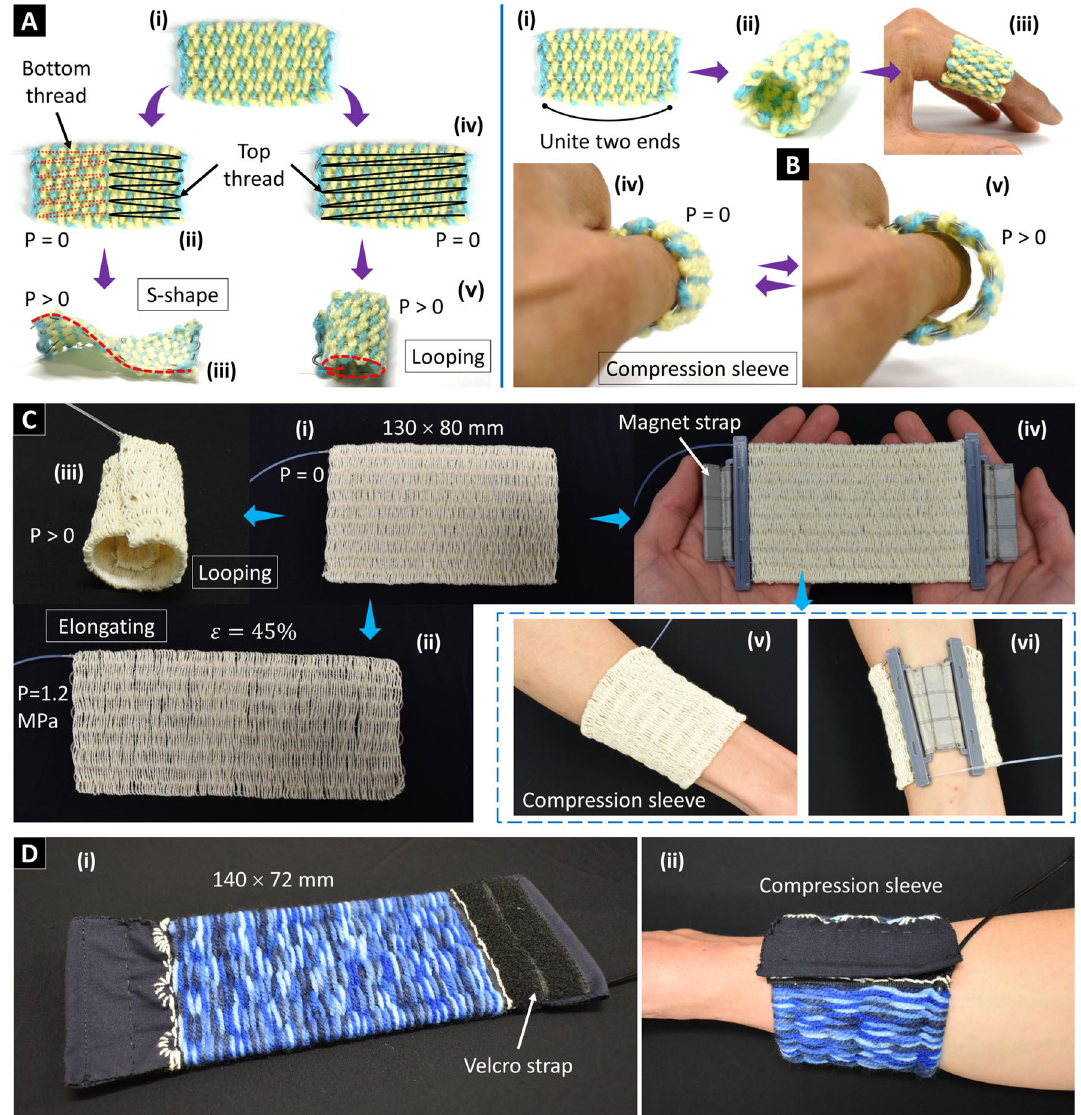
Figure 6. Capabilities of unidirectional weaving sheets. ( A ) Shape programmability by sewing thread to produce shape-shifting structures. ( B ) Compression sleeve for a finger. ( C ) Another weaving sheet embodiment and its implementation as a forearm compression sleeve. ( D ) Another compression sleeve prototype made of an AMF type M, acrylic yarns, and a Velcro strap. Detailed specifications can be found in the “Methods” embraced the human index finger (Fig. 7C). The meandering features of the knitting sheet offer great conform- ability and deformability, facilitating its use in smart garments (gloves, compression sleeves) that provide the wearers with comfort (by adaptability) and therapeutic effect (by compression force). Radial expansion. Besides 2D radial expansion in multiple directions, the circular weaving sheet can also be programmed to form a 3D structure. We constrained the centerline of the circular weaving sheet with acrylic yarns to disrupt its uniform radial expansion. As a result, the initial planar shape of the circular weaving sheet was transformed into a hyperbolic paraboloid-like shape (or a potato chip) upon pressurization (Fig. 7D). This shape-shifting capability can be implemented as a lifting mechanism, optical lens, legs for locomotion robots, or maybe useful for fashion design and bio-mimicking robots. Fabric reconfiguration. We have developed a simple technique to create a bending actuator—by sticking an AMF to a strip of non-stretchable fabric (Fig. 3). We leveraged this concept to create shape-programmable fila- ments, in which we can strategically allocate multiple active and passive segments in a single AMF to produce the desired shape. We fabricated and programmed four active filaments that could transform their shapes from straight lines into letters (UNSW) upon pressurization (Supplementary Fig. S4). This simple technique enables the shape-shifting capability of AMFs to turn 1D lines into 2D shapes and possibly 3D structures.